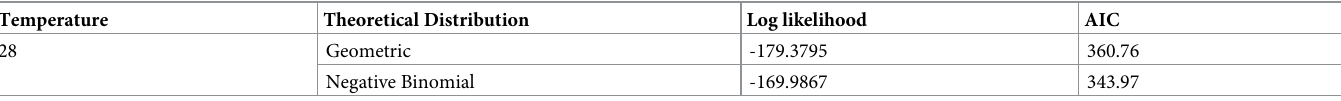
Table 4. Comparison of distributions shows that negative binomial is a better fit to the 28˚C bite data (time between bites) compared to the geometric.